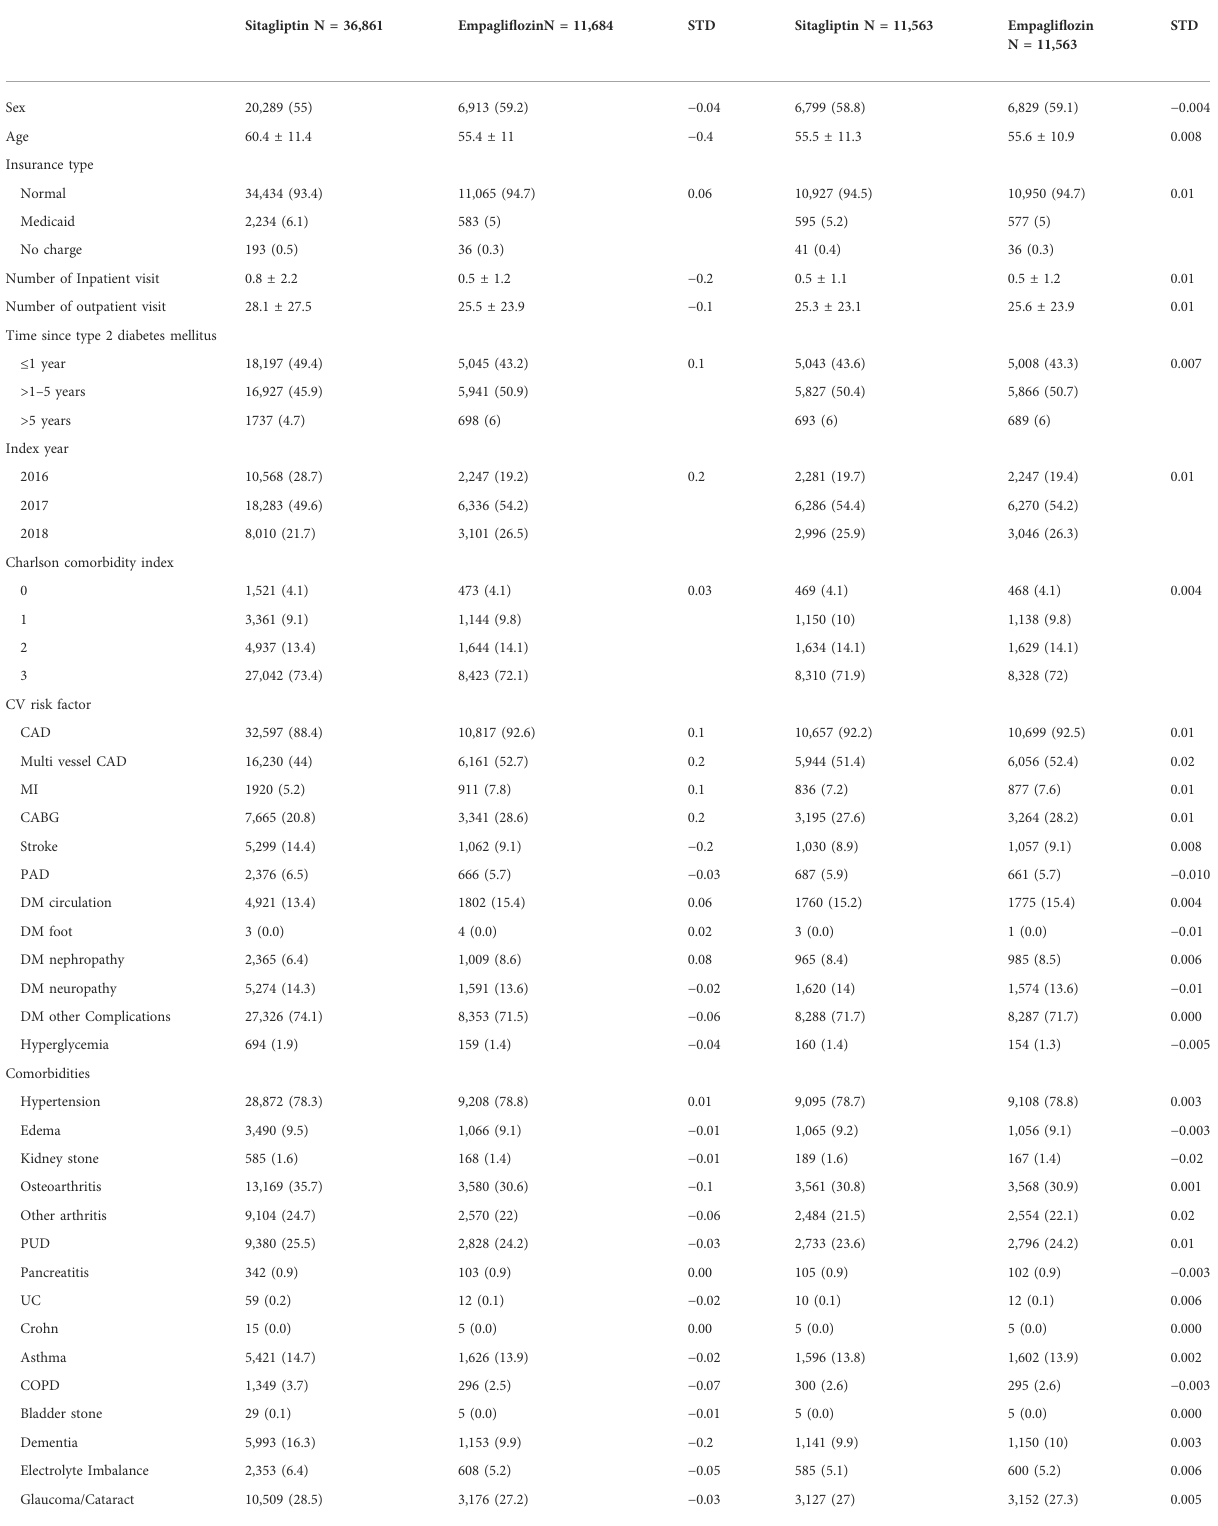
TABLE 1 Baseline